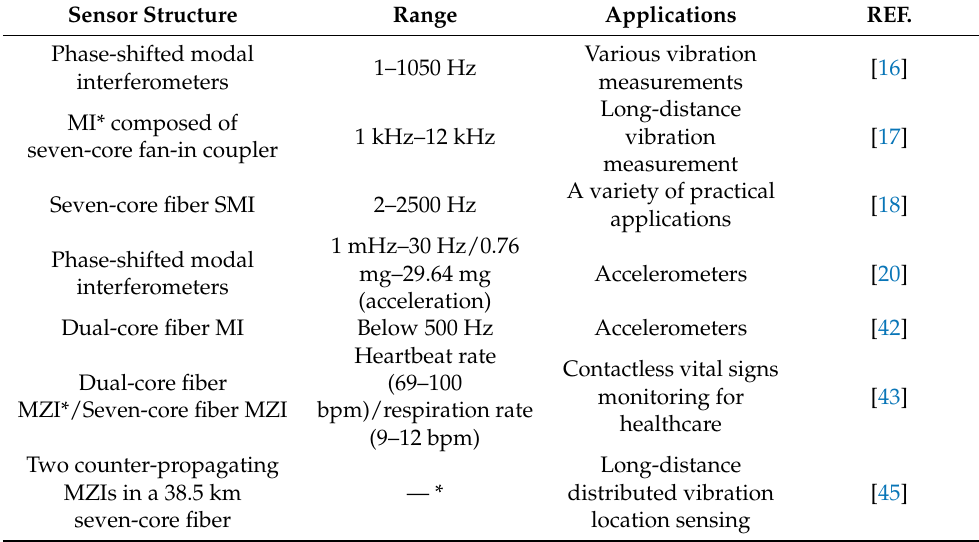
Table 2. Comparison of MCF interferometer-based vibration sensors. Sensor